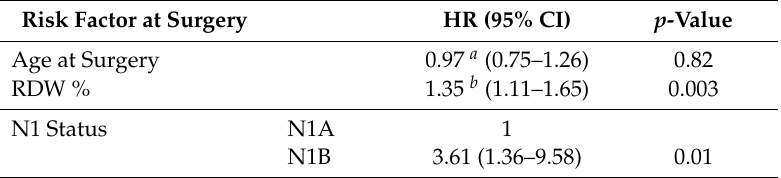
Table 6. Multivariable disease-free survival